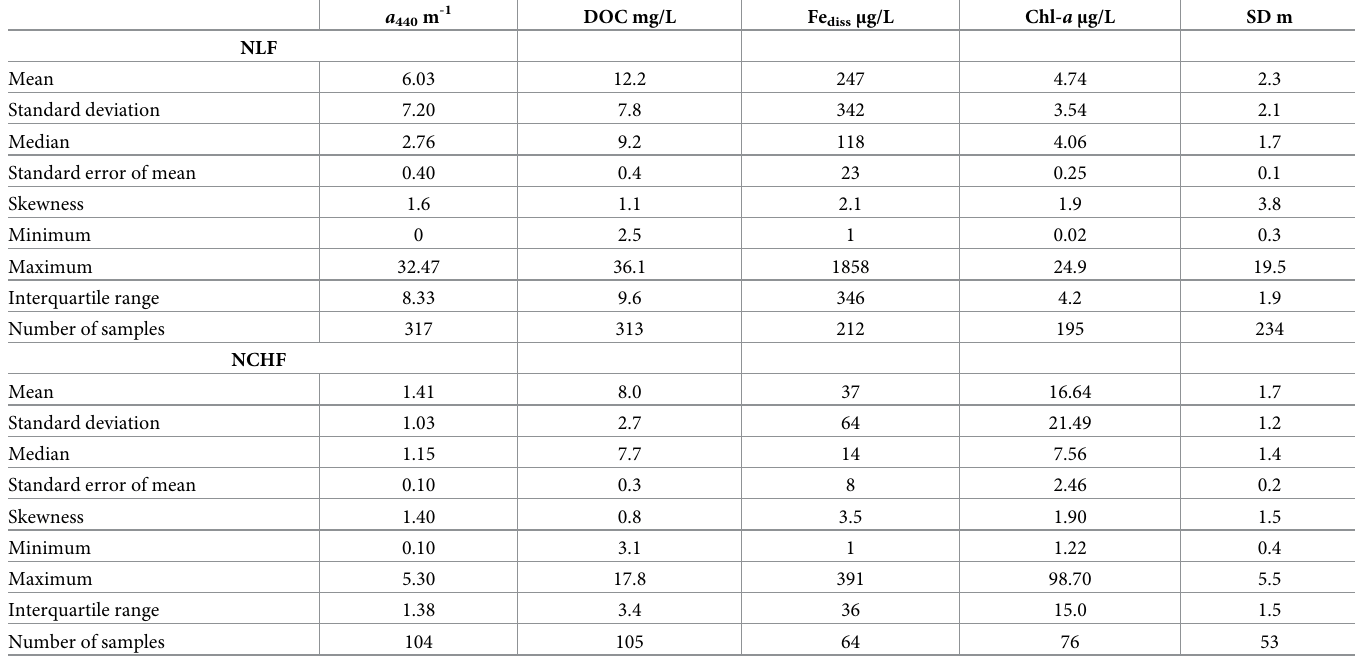
Table 1. Summary statistics for a 440 , DOC, and Fe diss and two basic limnological variables in the NLF and NCHF